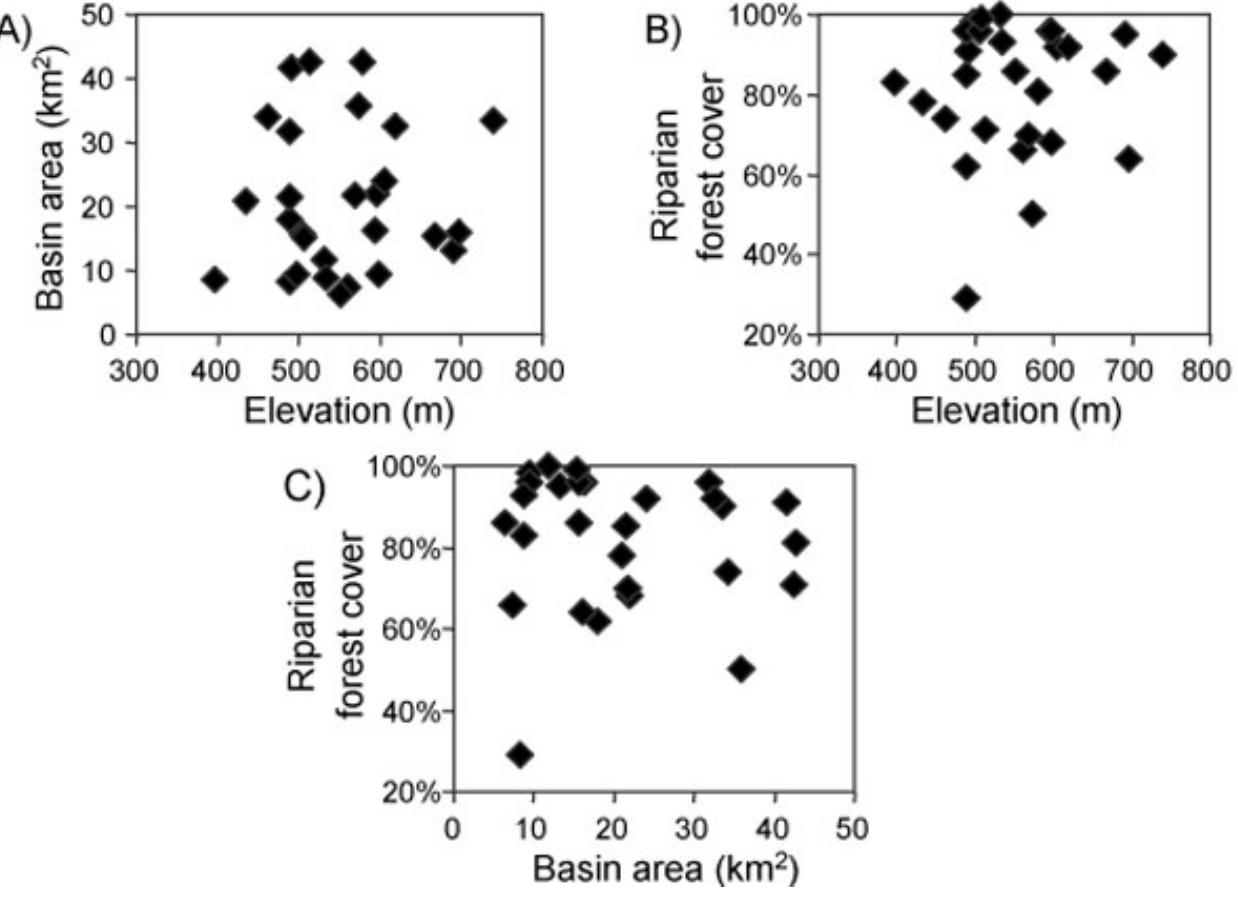
Fig. 6. Plots of basin area, elevation, and percent riparian forest cover illustrate the range of conditions across primary sampling sites and independence among these landscape